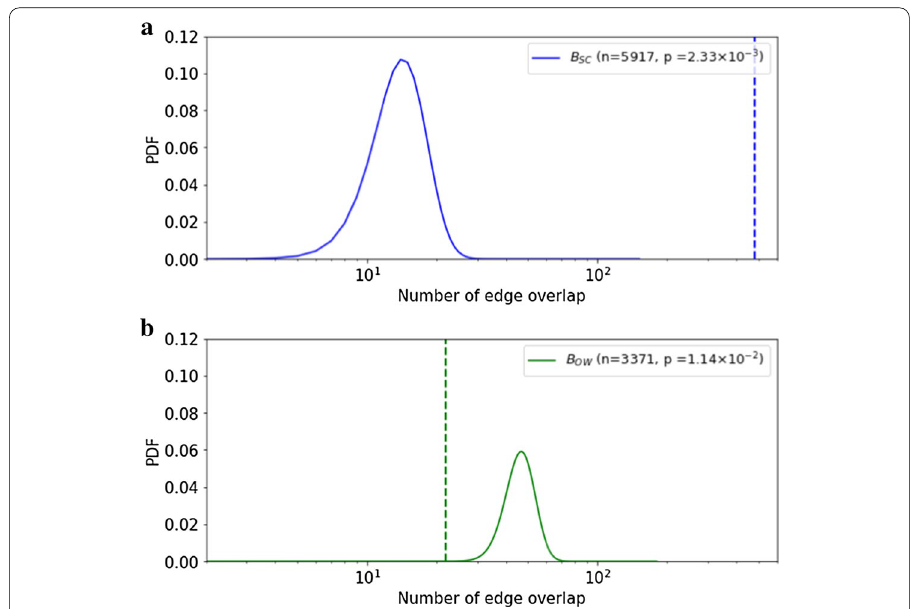
Fig. 6 Comparison with binomial distribution. The solid lines represent binomial distributions B ( n,p α ) , where p α is the conditional probability that we can choose the overlapped edge between drug pipeline layer and the α -th layer from n edges for a for supply chain and b ownership. The dashed lines represent observed values listed in Table 5, that is, 480 for α = 2 and 22 for α =